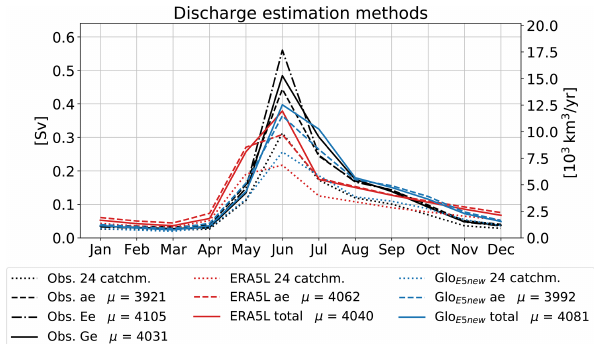
Figure 4. Pan-Arctic discharge estimates using hydrological anal- ogy (ae) and monthly correction factors from ERA5-Land (Ee) and (Ge) for the period of 1981–1999. Long-term annual GloFAS E5 new means in km 3 yr − 1 are given in the